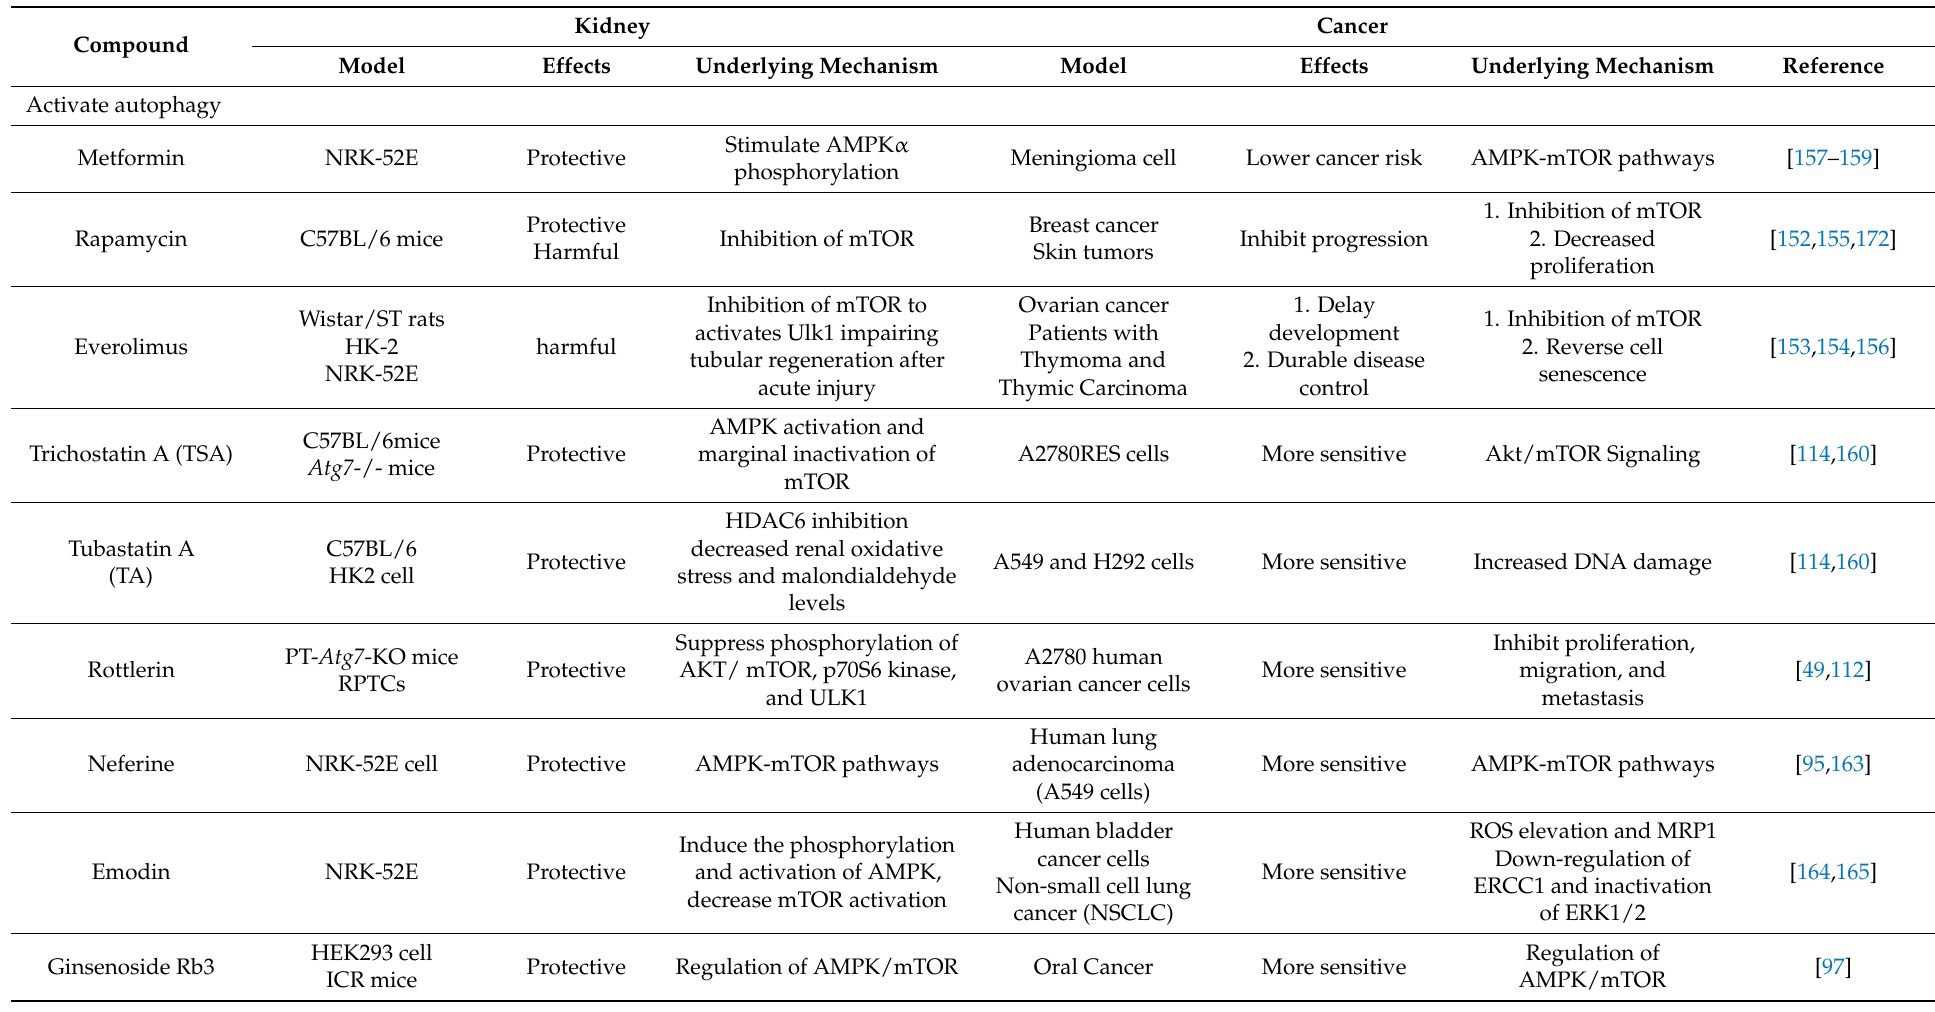
Table 2. Therapeutic compounds targeting autophagy during cisplatin